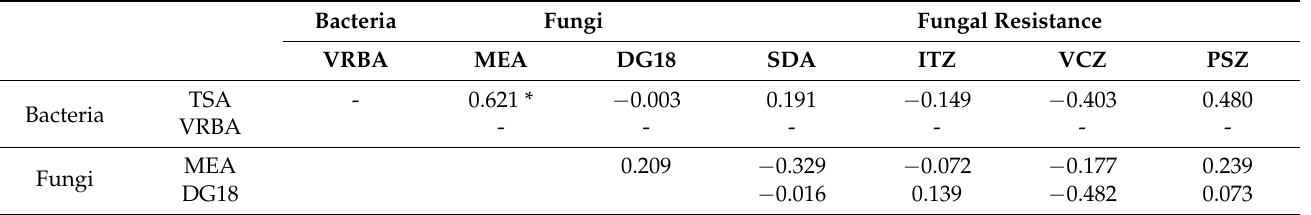
Table 3. Study of the relationship between bacterial and fungal contamination and fungal resistance: Results of Spearman’s correlation